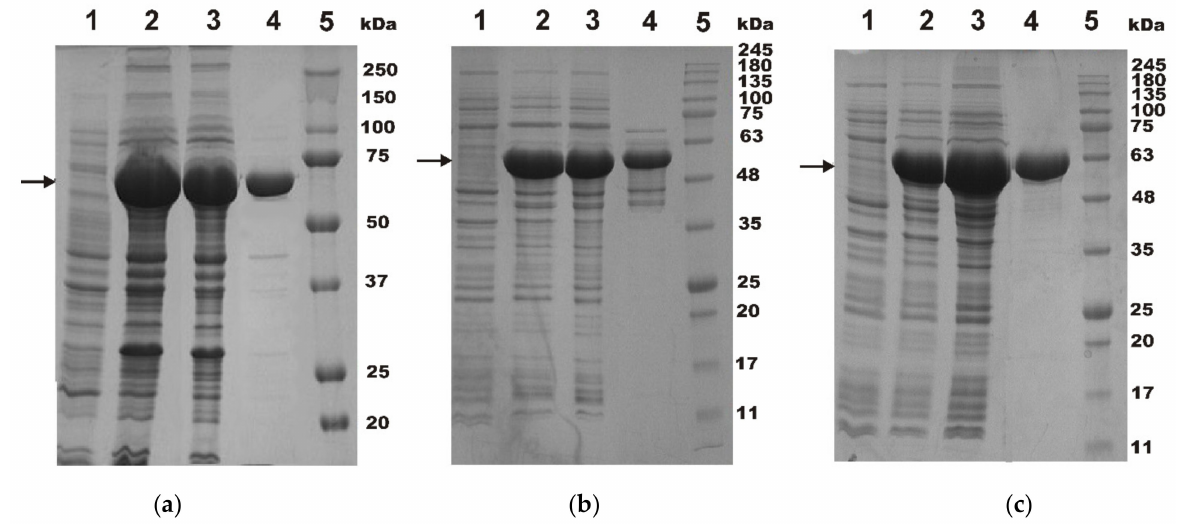
Figure 5. 12.5% SDS-PAGE analysis of MBP-TnI ( a ), MBP-MIA ( b ) and MBP-Surv ( c ) purification using starch-MNPs. Lanes: 1—whole-cells lysates before IPTG induction; 2—whole-cell lysates after IPTG induction; 3—cytoplasmic fraction; 4—fractions after elution by 10 mM maltose; 5—standard proteins (BioRad, Hercules, CA, USA), molecular weights are shown with numbers. Arrows show hybrid proteins